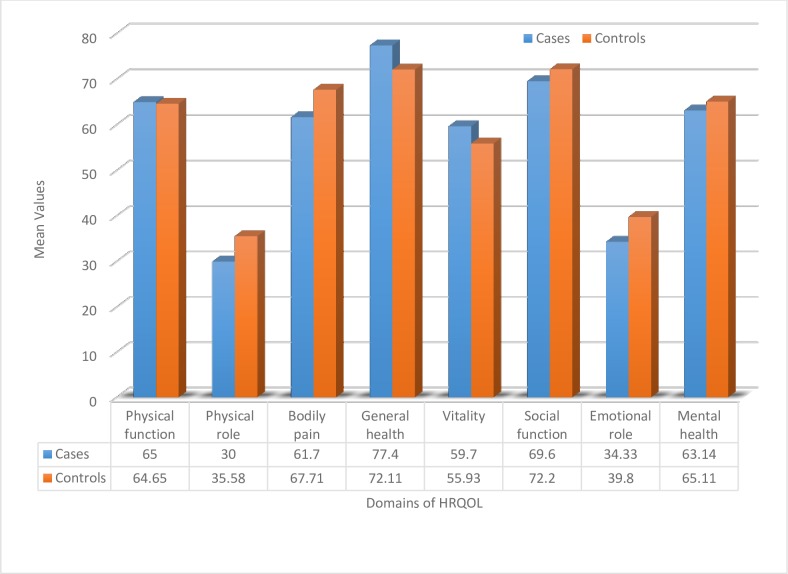
Mean difference of HRQOL domains between case and control groups in eastern Ethiopia from February to July 2017.